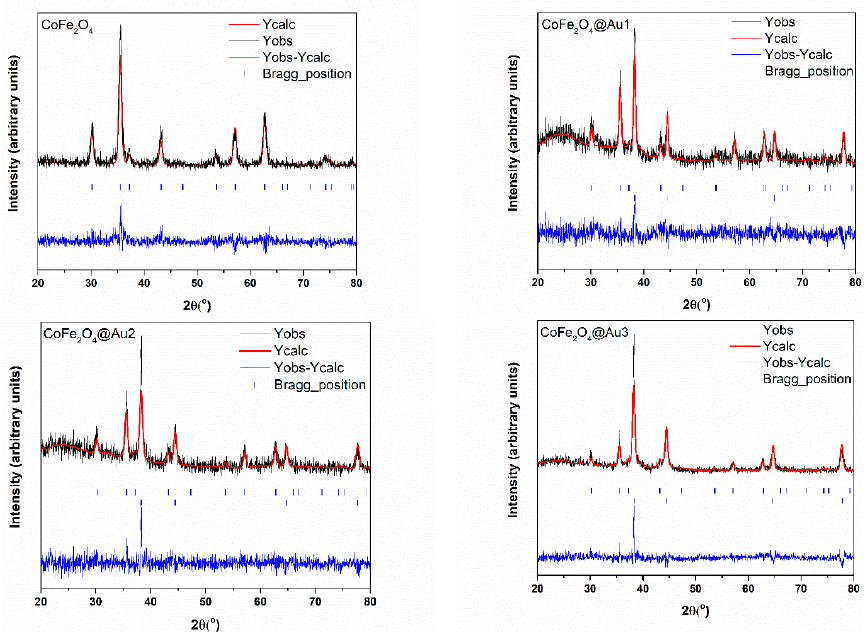
Figure 1. XRD patterns of CoFe 2 O 4 and CoFe 2 O 4 @SiO 2 @Au nanocomposites and the results of Rietveld refinements. Table 1. Compositions, lattice parameters, crystallites sizes, magnetizations and coercive fields.